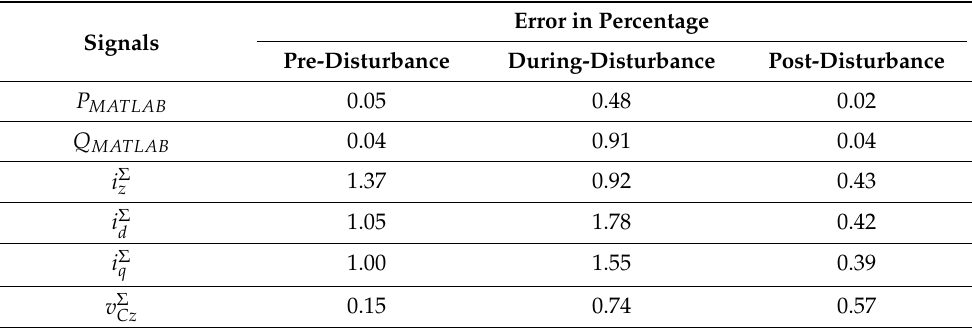
Table 3. MAE in the mathematical model during the step change in Active Power from 1 p.u. to 0.3 p.u. at t = 0.6 s.